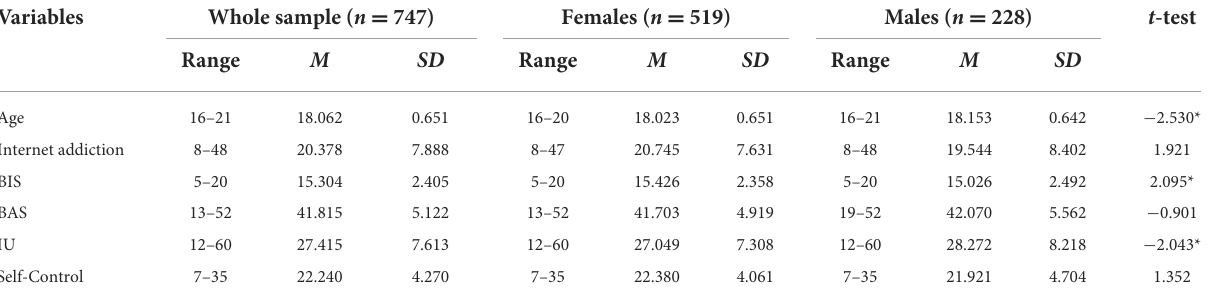
TABLE 1 Descriptive statistics among the variables.